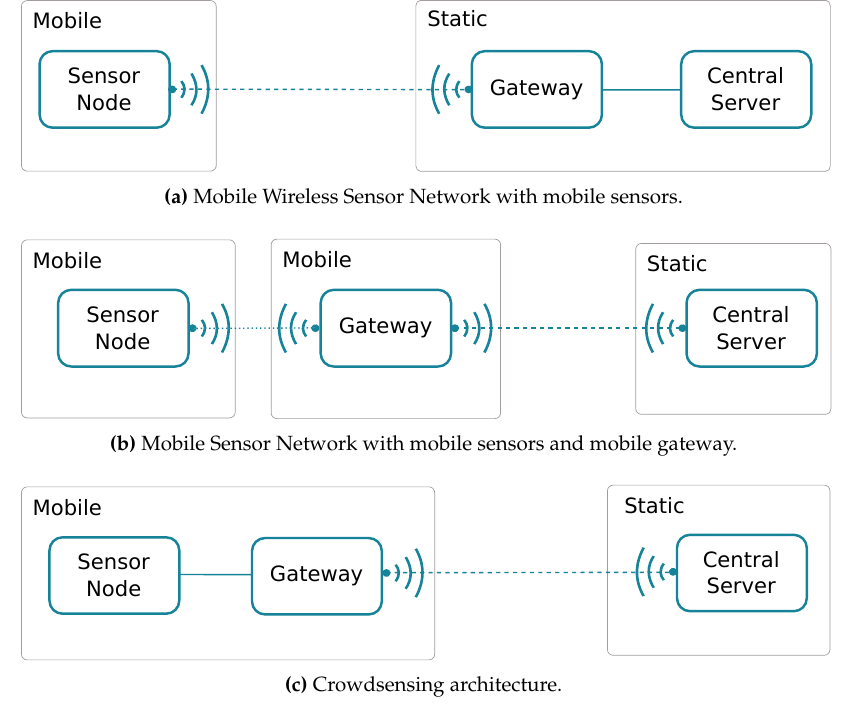
Figure 7. Different types of Mobile Sensor Networks’ structures.